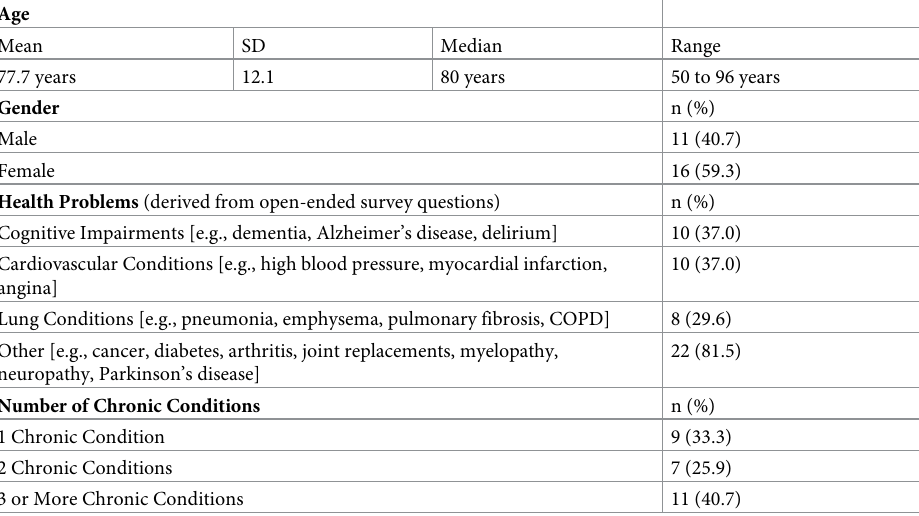
Table 4. Health links patient characteristics (n =